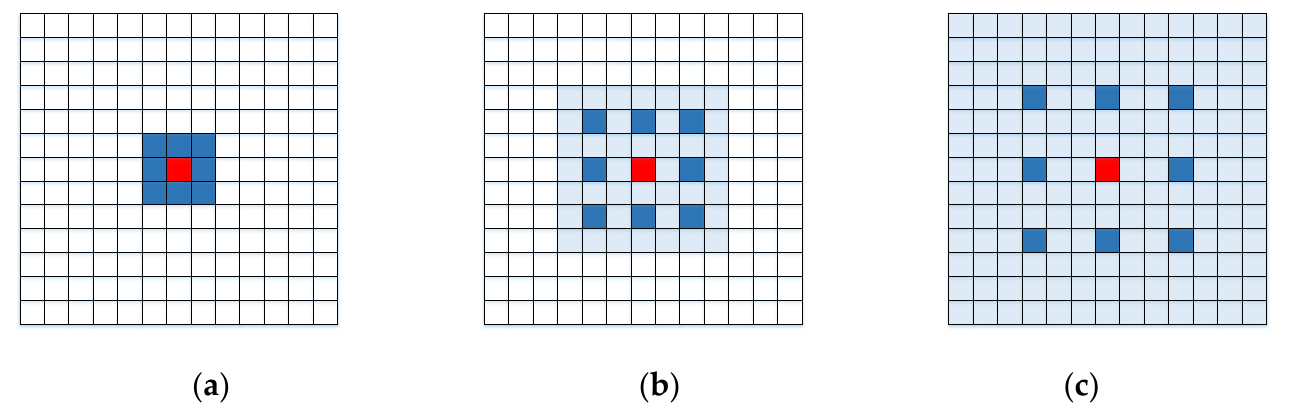
Figure 4. Atrous convolution with different dilation rates. ( a ) r = 1; ( b ) r = 2; ( c ) r = .